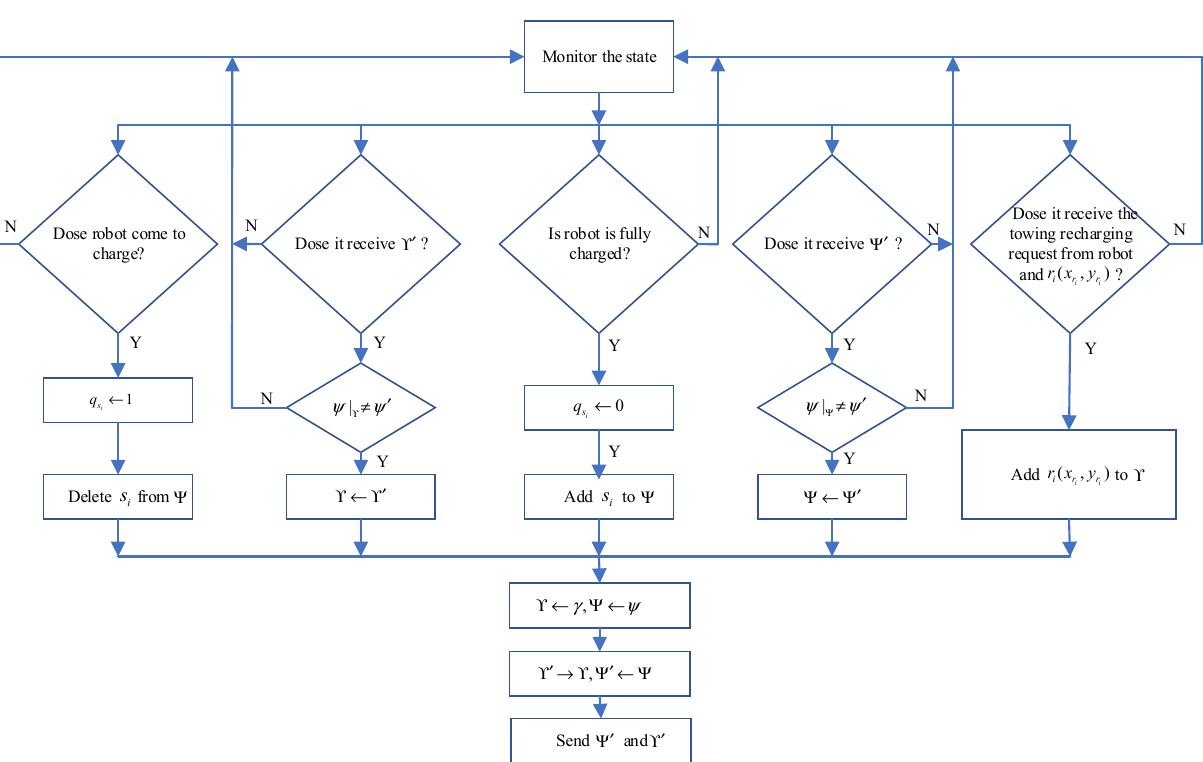
Figure 2. Flow diagram of charging station receiving and sending ϒ and Ψ .